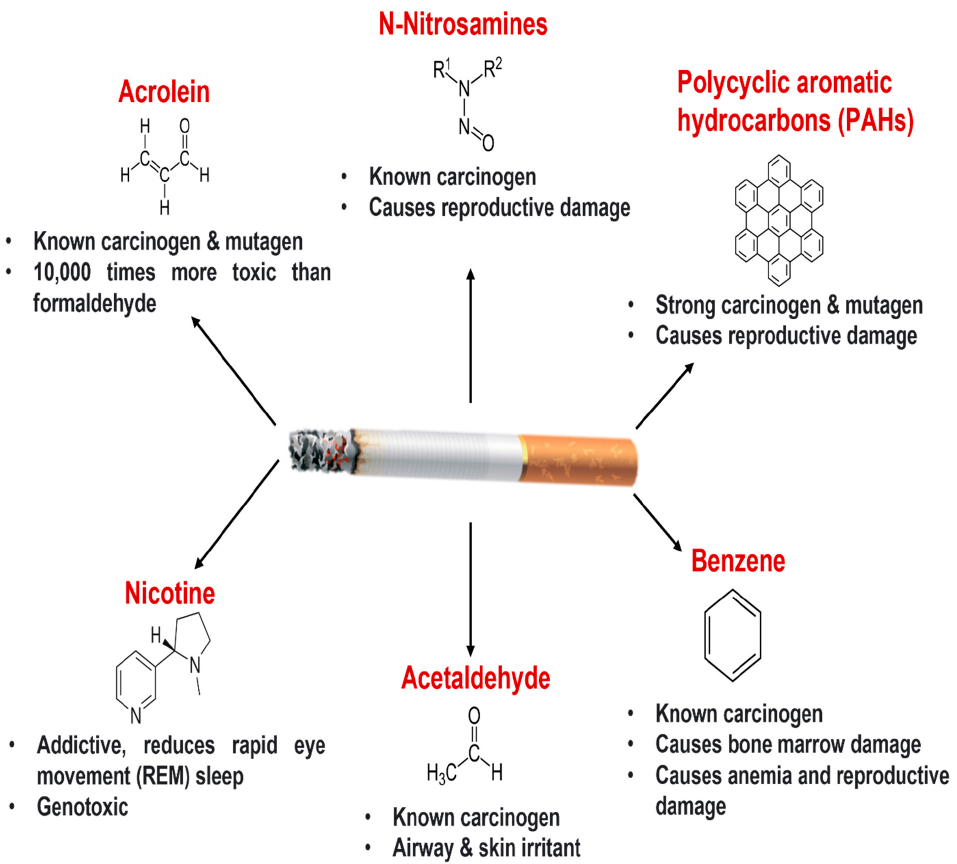
Figure 1. Cigarette smoke components and their pathological effects: Cigarette smoke contains more than 4000 chemicals that exert cytotoxic, mutagenic, and carcinogenic effects. Nicotine is the prime addictive ingredient of cigarette smoke which is genotoxic and has immunomodulatory effects [11]. Acrolein has carcinogenic and mutagenic potential in animal models (rats and mice) and humans [34,35]. The tobacco-specific nitrosamines N-nitrosonornicotine (NNN) and nicotine-derived nitros- amine ketone (NNK) may cause reproductive damage and exhibit potent carcinogenic effects in rat and human models [34–37] . Polycyclic aromatic hydrocarbons (PAHs) are immunosuppressive, carcinogenic, mutagenic, and cause reproductive damage [38–41] . Benzene is another toxic compo- nent in cigarette smoke that causes anemia, reproductive damage, bone marrow damage, and exerts carcinogenic potential [42–46] . Acetaldehyde is known as a skin and airway irritant and has car- cinogenic properties [34,47,48]. In addition to these well-known carcinogens and mutagens, ciga- rette smoke also contains oxidants such as carbon monoxide, nitric oxide, hydrogen peroxide, per- oxynitrate, and peroxynitrite [49]. These oxidants cause lung damage through depletion of glutathi- one and other antioxidants, inactivation of protease inhibitors, enhancement of the respiratory burst, and can also cause direct damage to lipids, nucleic acids, and proteins [15].